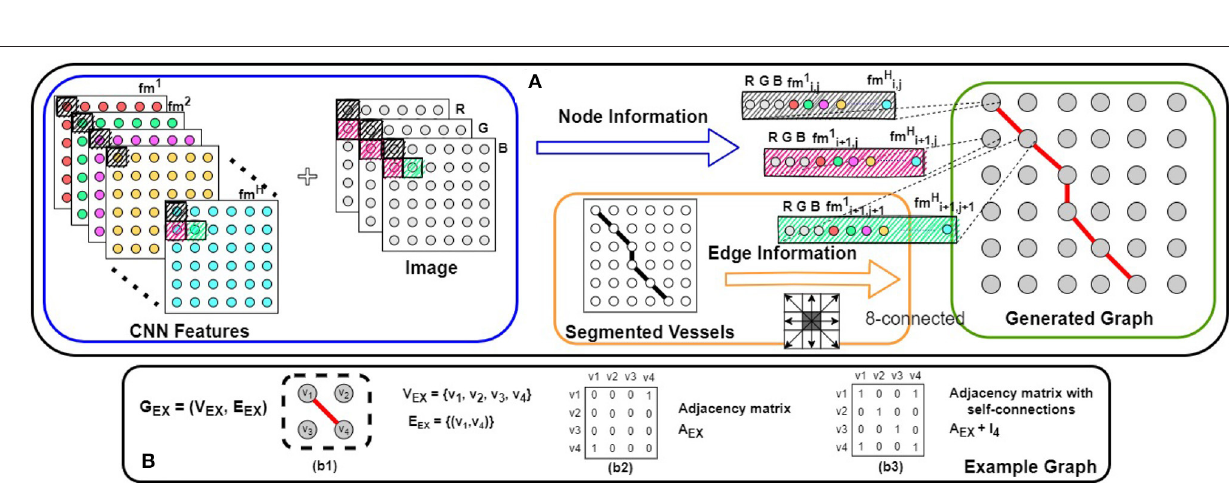
Frontiers in Medicine |